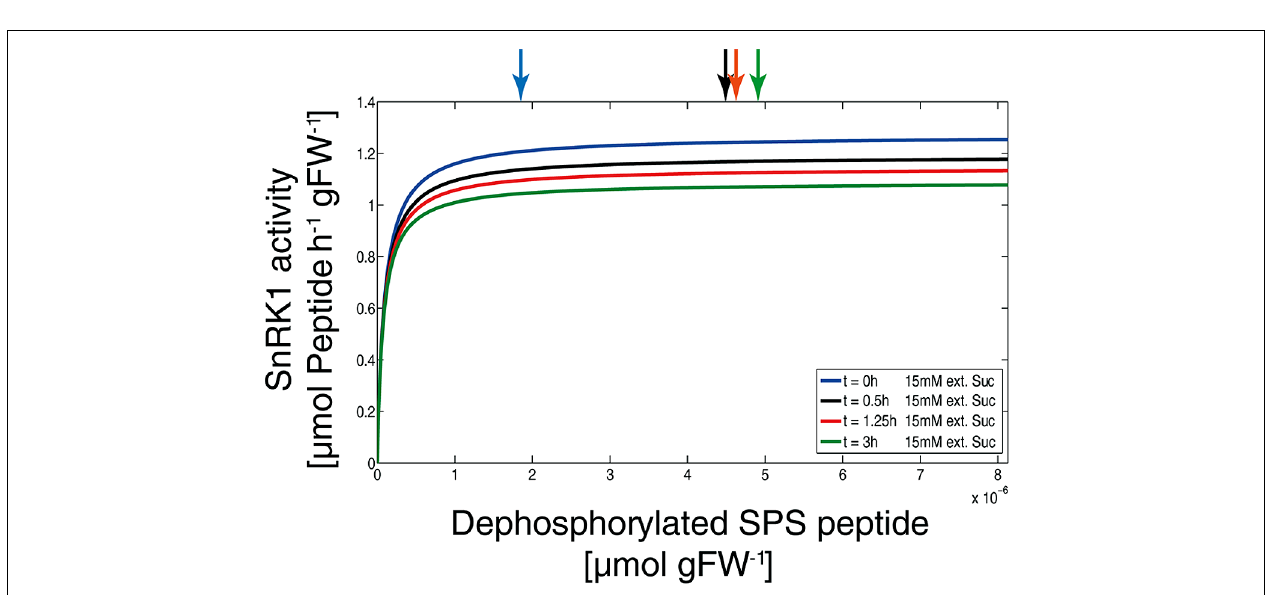
Arrows on the top indicate the level of substrate, i.e., of dephosphorylated SPS peptide, at the time points 0 h (blue), 0.5 h (black), 1.25 h (red), and 3 h (green) after external sucrose supply (15